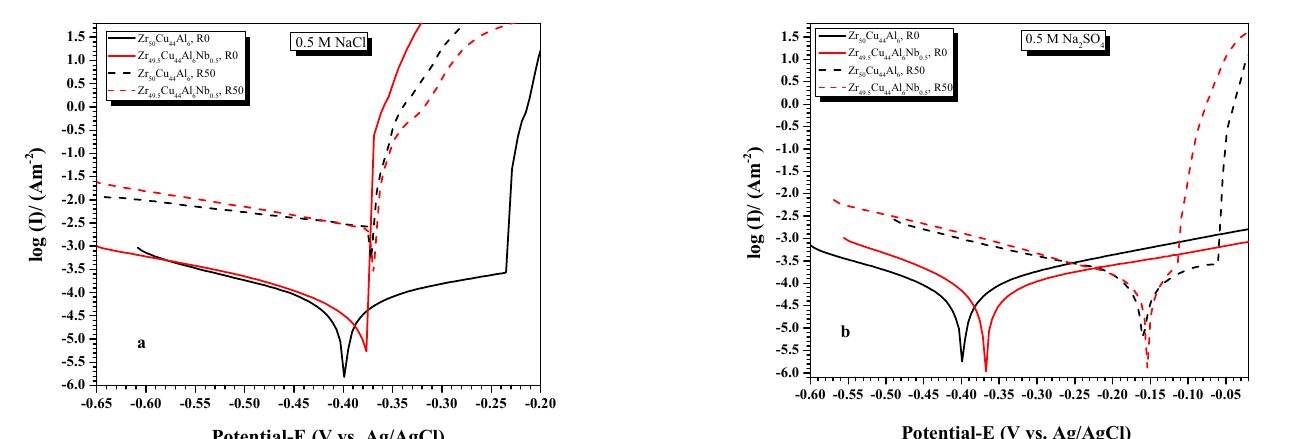
Figure 7. Anodic polarization curves of R0 and R50 of A1 and A2 ribbons in ( a ) 0.5 M NaCl and ( b ) 0.5 M Na 2 SO 4 solutions at 298 K open to the air. Table 1. Corrosion parameters of A1 (Zr 50 Cu 44 Al 6 ) and A2 (Zr 49.5 Cu 44 Al 6 Nb 0.5 ) ribbons at R0 and R50 in 0.5 M NaCl and 0.5 M Na 2 SO 4 solutions.